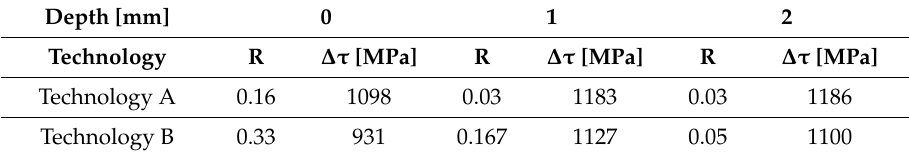
Table 3. E ff ective fatigue ratios, R, for both manufacturing technologies of the torsion bar. Depth